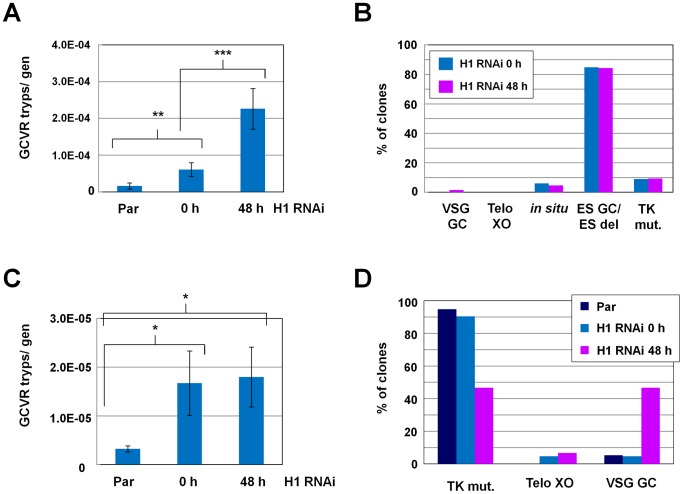
Depletion of histone H1 results in an increase in VSG switching.
A. The frequency of generation of ganciclovir resistant (GCVR) trypanosomes per generation (GCVR tryps/gen) in parental (Par) T. brucei and 221pGFPhyTK-H1 cells in the presence of histone H1 RNAi for the time indicated in hours (h). Bars indicate the mean of independent experiments [parental n = 3; H1 RNAi cells (0 h and 48 h histone H1 RNAi), n = 5]. The standard deviation is indicated with error bars. A higher rate of generation of GCVR clones as a measure for VSG switching was observed in uninduced T. brucei 221pGFPhyTK-H1 cells (containing the histone H1 RNAi construct) compared with parental cells (statistical significance **, P<0.01). However, there was a statistically significant increase in this frequency after the induction of histone H1 RNAi for 48 hours (***, P<0.001). B. Mechanism of VSG switching in clones from seven independent cultures after the induction of histone H1 RNAi for 48 hours (n = 64) (purple bars) or in four independent cultures generated in the absence of histone H1 RNAi (n = 33) (blue bars). The genotypes and phenotypes of the clones were determined using microscopy and PCR, allowing determination of the VSG switching mechanism used. The percentage of clones that had switched using each mechanism is plotted. VSG switch mechanisms are as indicated in Figure 8, as well as cells which appeared to have mutated the TK gene (TK mut.) as determined by their resistance to GCV and continued expression of VSG221. C. Frequency of generation of GCVR clones per generation (freq/gen) in parental (Par) and 221pGFPhyTK-H1 cells grown in the absence (0 h) or presence of histone H1 RNAi for 48 hours (48 h). These experiments were conducted in the presence of puromycin to select for DNA rearrangements in the vicinity of the telomeric VSG. Bars indicate the mean of three independent experiments with standard deviation indicated with error bars. As shown in panel A., cells containing the H1 RNAi construct show a statistically significant increase in the frequency of ganciclovir resistant cells (statistical significance *, P = 0.024). This frequency does not further increase after depletion of histone H1 for 48 hours (statistical significance of increase compared with parental *, P = 0.014). D. Increased VSG switching mediated by gene conversion (GC) in cells depleted for histone H1. VSG switching was monitored in T. brucei 221pGFPhyTK-H1 cells in the absence (0 h) or presence of H1 RNAi for 48 hours. VSG switching mechanisms were determined in clones derived from at least three independent cultures for each experiment. All GCVR clones were generated in the presence of puromycin to select for VSG switches mediated by DNA rearrangements at the telomere of the active ES. VSG switching mechanisms were determined using immunofluorescence microscopy and PCR as in panel B. Using parental cells (Par) or uninduced histone H1 RNAi cells (0 h) ∼90% of the obtained clones (Par n = 19; H1 RNAi 0 h n = 21) continued to express VSG221, indicating that they are TK mutants (TK mut.). However, when histone H1 RNAi had been induced for 48 hours, less than half of the generated clones were TK mutants, and ∼33% had switched through VSG gene conversion (VSG GC). Clones that had switched through telomere exchange (Telo XO) were also observed using this assay.